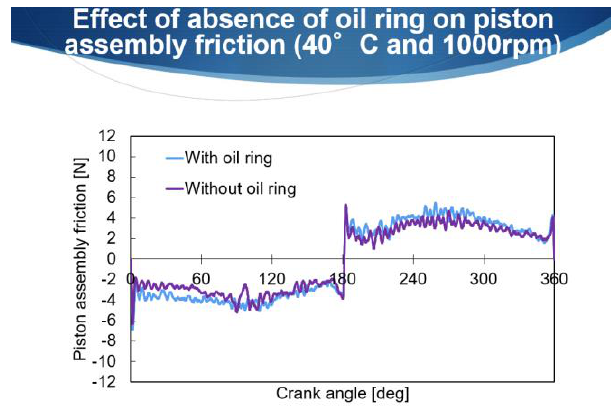
Fig. 7. Crank-angle resolved piston assembly friction for two different piston configurations under low-speed steady state operating conditions [38]